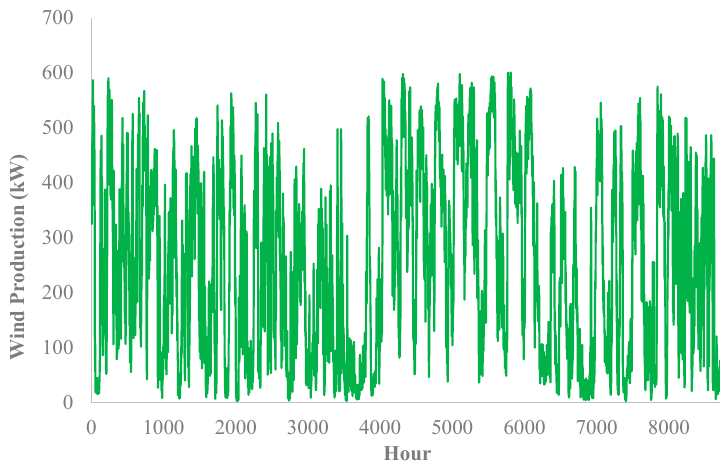
Figure 4. Wind Production during the examined year.